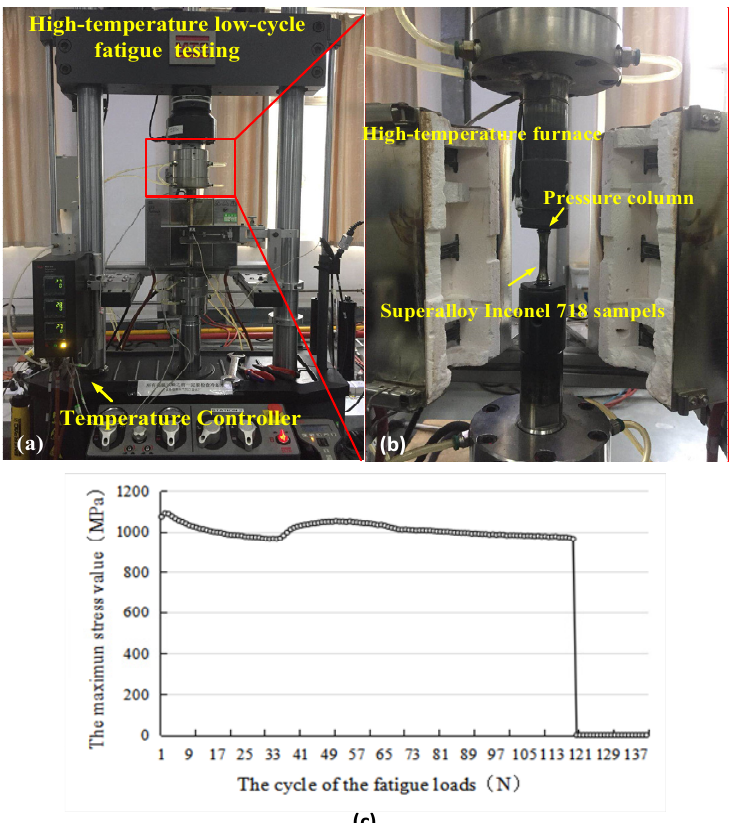
Figure 6. High-temperature low-cycle fatigue life test of Inconel 718. ( a ) Fatigue test machine; ( b ) clamping of sample during experiment; ( c ) the maximum stress changes with the number of cycles.